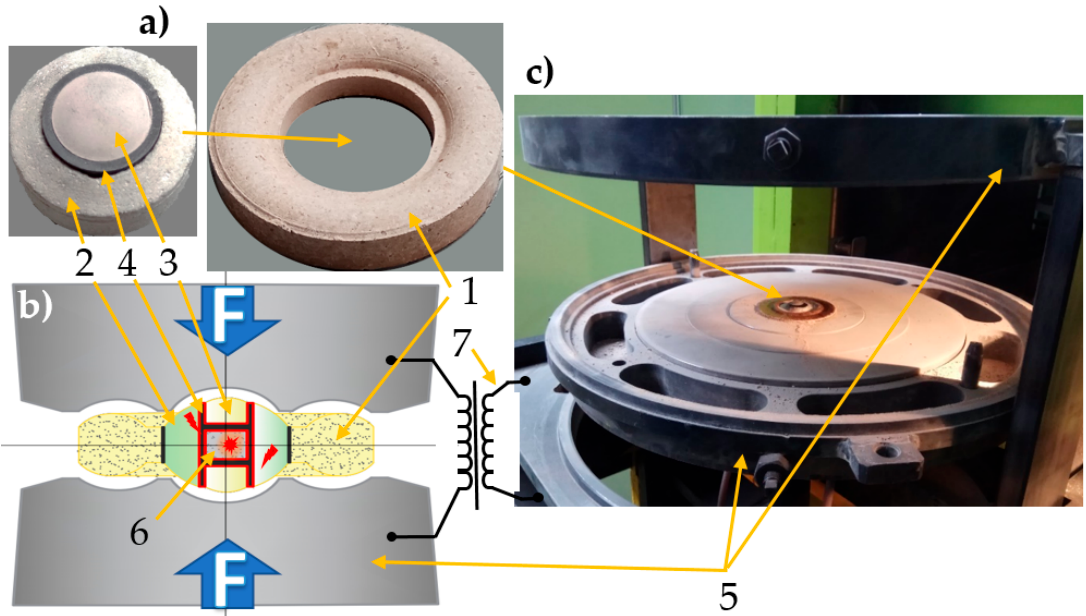
Figure 2. High Pressure HPHT/SPS Process: ( a ) view of the container: ceramic gasket 1—outer part, 2—inner central part, 3—ceramic disk, 4—graphite resistance heater, ( b ) cross—section of the container and the method of fixing the container between the anvils of the device, ( c ) view of the anvils and the container after sintering the sample—5—anvils, 6—the powder mixture placed in a toroidal chamber, 7—pulsed electrical generator.